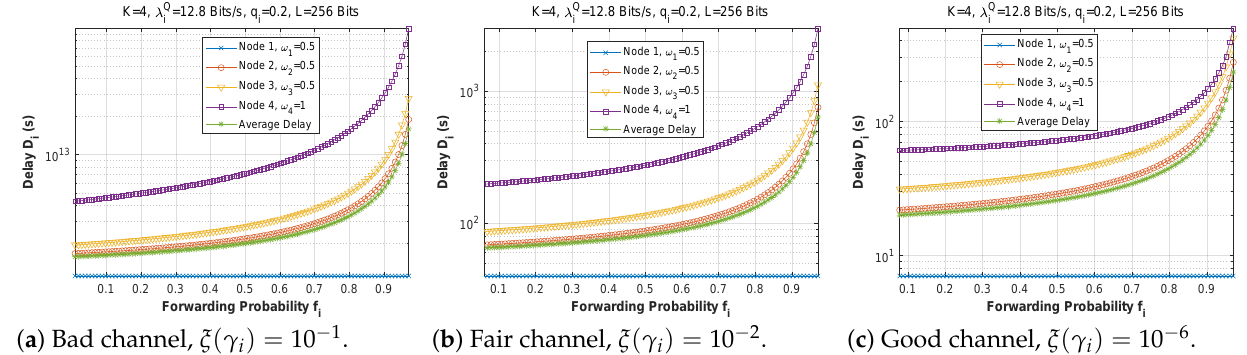
Figure 6. Setting 1: The delay experienced at each mobile device when varying the forwarding probability with the bit error rate ξ ( γ i )